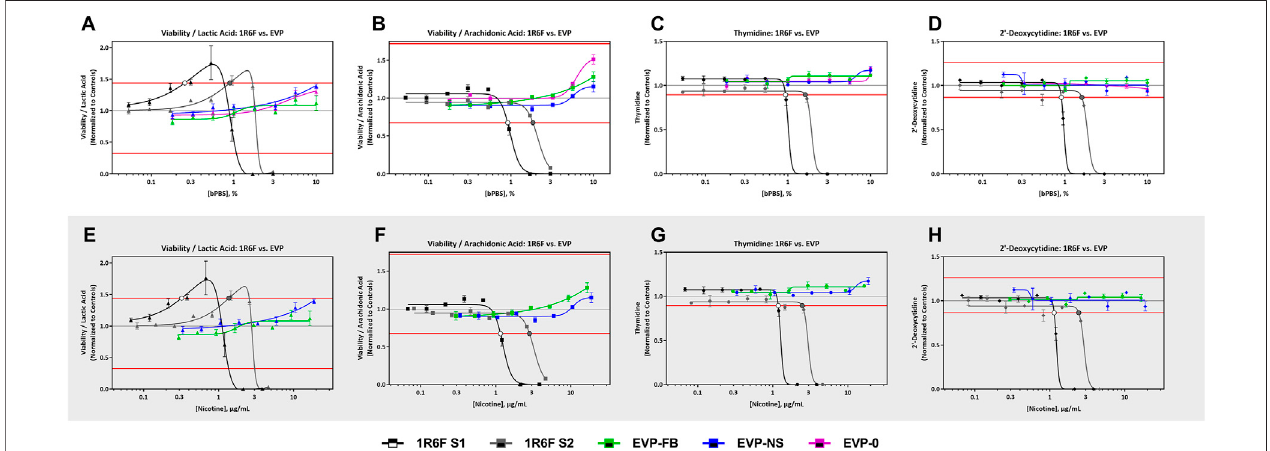
FIGURE 4 | 1R6F vs EVPs Cell Viability/Lactic Acid, Cell Viability/Arachidonic Acid Thymidine, and 2 ′ -Deoxycytidine Response Comparison. The x-axis is the concentration (% bPBS) of the test article (A – D) or nicotine (µg/mL) (E – H) . The y-axes are the reference treatment normalized (fold change) values for each metabolite/ ratio. The horizontal red lines represent the metabolite-speci fi c prediction thresholds. The black bordered circles represent the nicotine concentration where the dose- response curve crossed the metabolite-speci fi c prediction